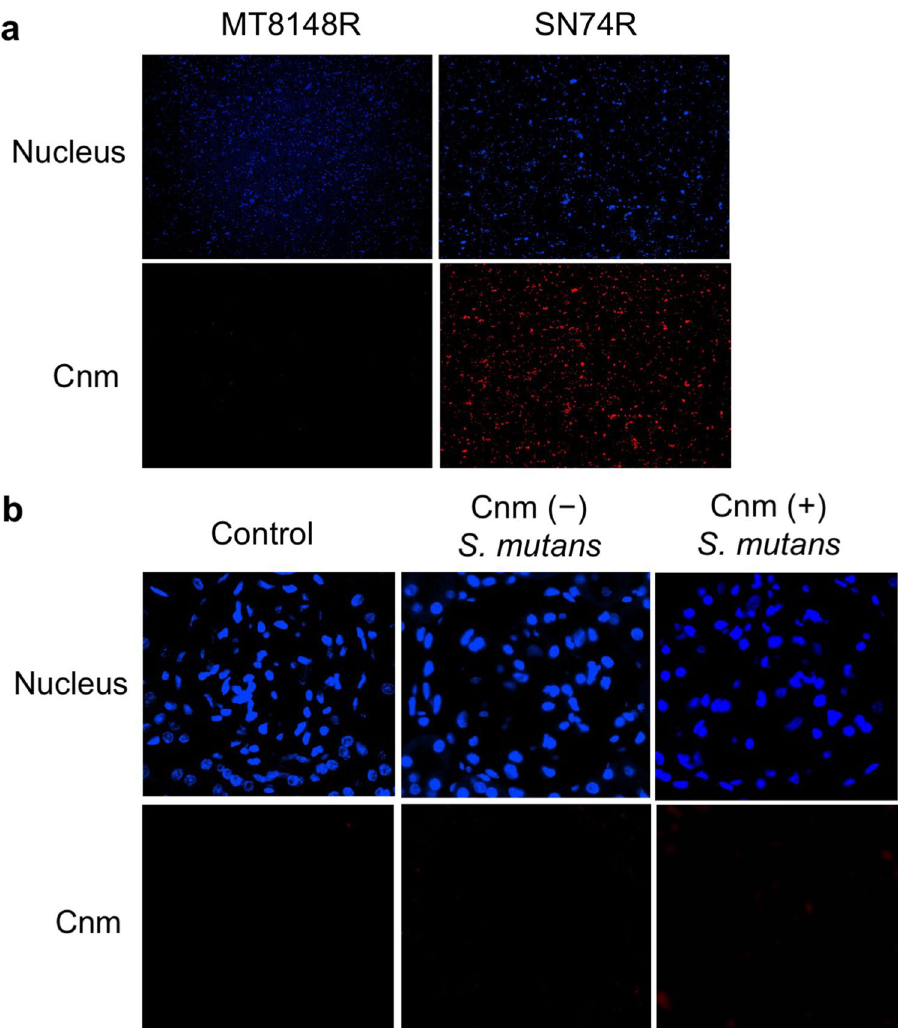
Figure 5. Representative histopathological appearance of bacteria and kidney tissues by immunohistochemistry with a Cnm-specific antibody. The first image shows nuclear staining. The second image shows staining with an anti-Cnm antibody. ( a ) Bacteria. ( b ) Kidney